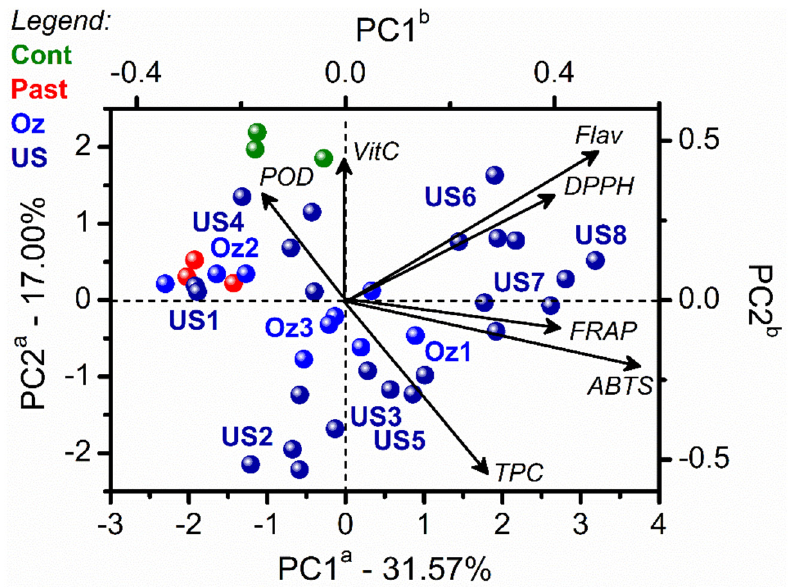
Figure 1. PCA biplot (scores and loadings) from cashew apple juices before (control, green) and after thermal PAST (red), non-thermal processing by OZ (light blue), and US (dark blue). See details in Table 1. The letter a in the PC axes refers to scores axes, and b refers to loadings axes with variables represented by vectors from the origin.